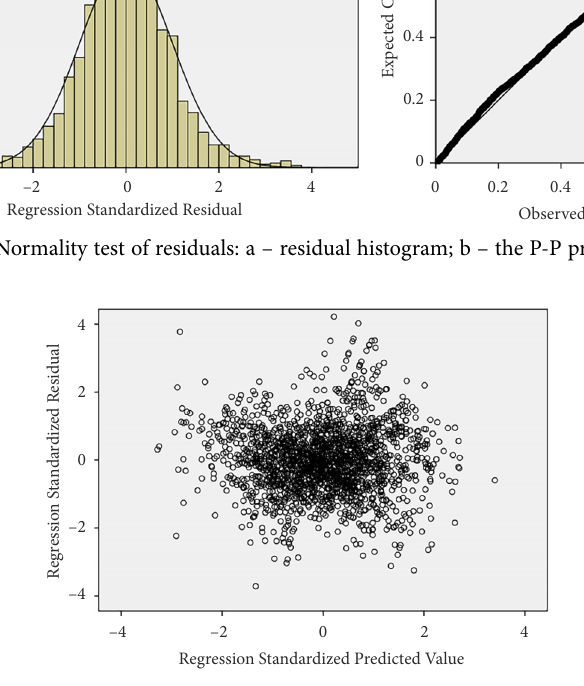
Figure 15. The scatterplot of predicted value and standardized